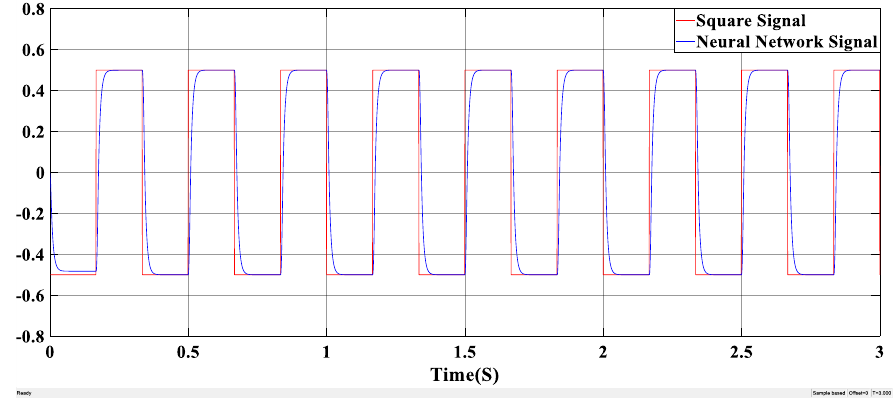
Figure 15. A square wave tracing experimental waveform.